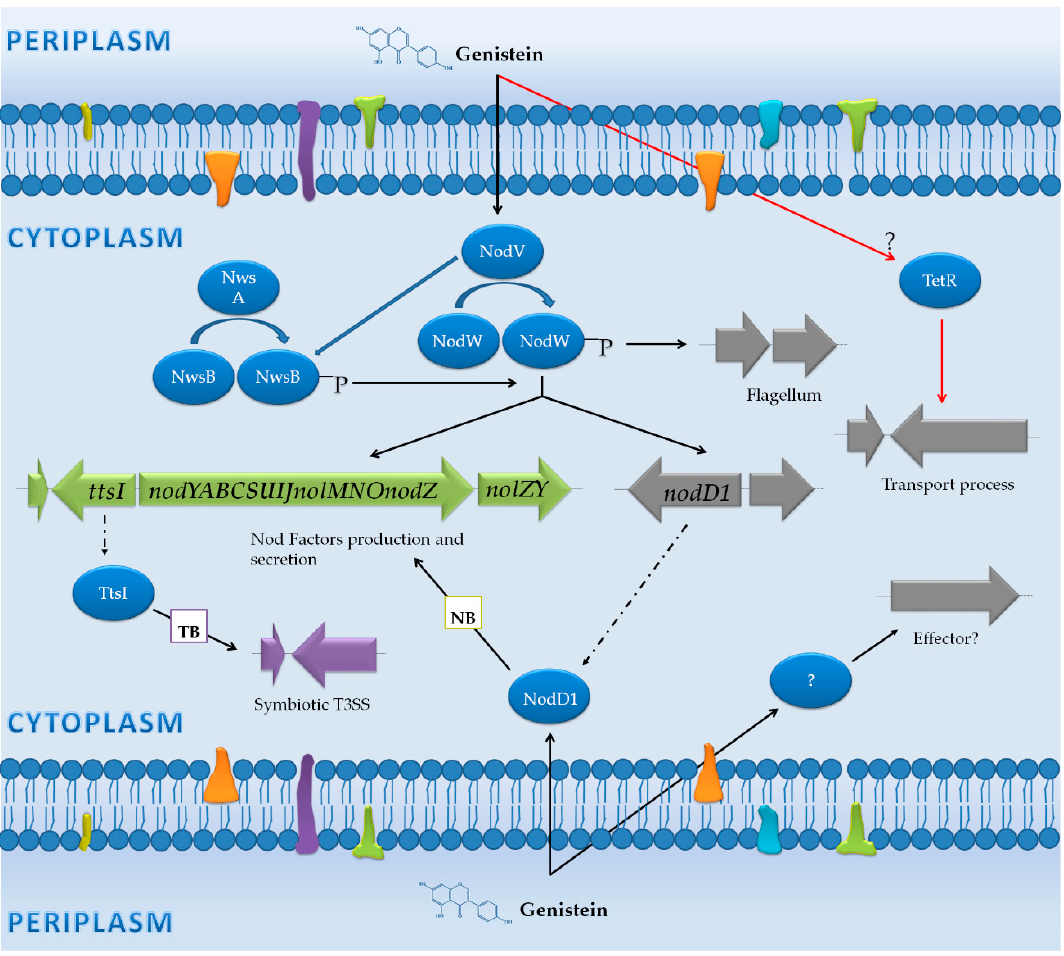
Figure 2. Transcriptomic response in the presence of genistein in B. japonicum USDA 110. Proteins are illustrated by blue circles. Protein phosphorylation processes are indicated by blue arrows. The DNA to protein translation process is represented by dotted arrows. Activation and repression of genes are indicated by black and red arrows, respectively. Genes regulated by a nod box or a tts box are represented in green and purple, respectively. Genes which are not controlled by a nod box or a tts box are indicated in grey. NB: nod box; TB: tts box; T3SS: type 3 secretion system.